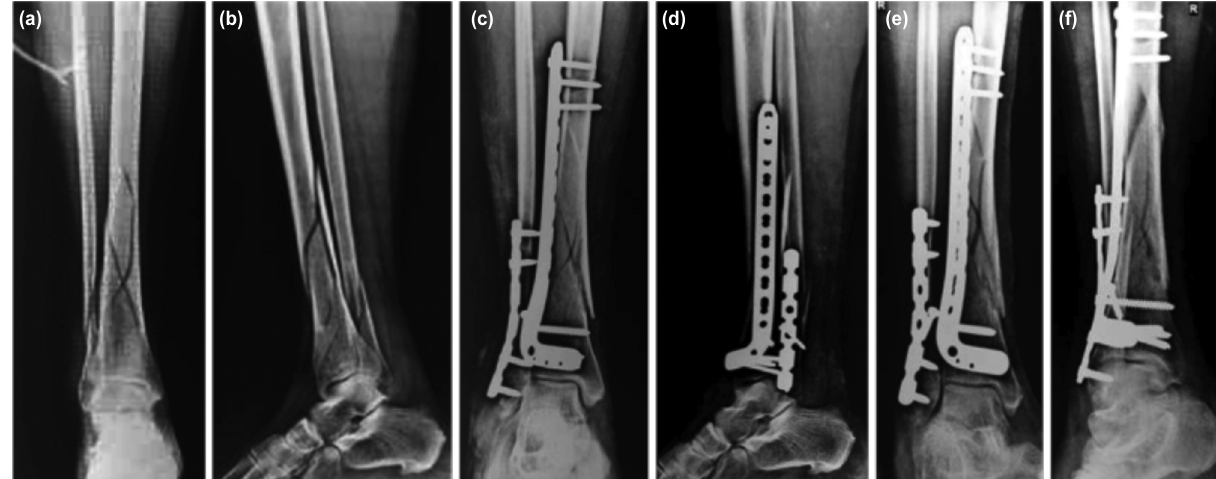
Pre-operative radiographs of intra-articular distal tibia-fibula fracture AO Type 44-C3 showing (a) antero-posterior and (b) lateral Fig. 1: view. While, immediate post-operative radiographs showing ORIF with plating done in (c) antero-posterior view and (d) lateral view. Three months follow-up radiographs of ORIF with plating showing (c) antero-posterior and (d) lateral view.